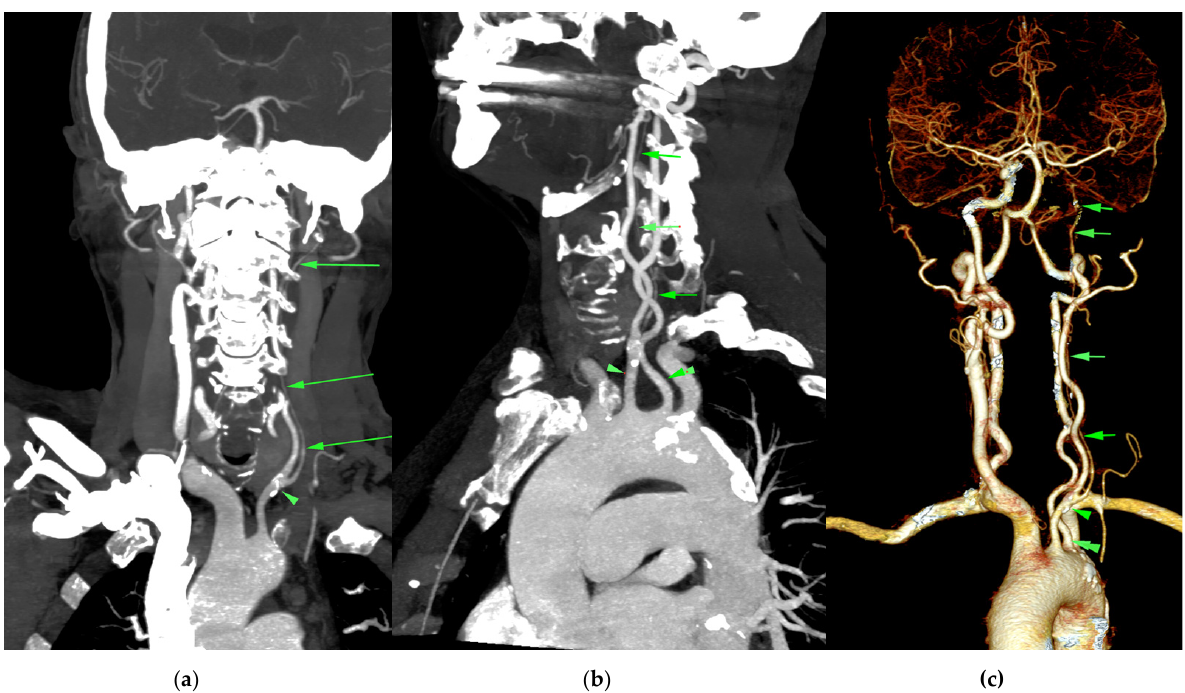
Figure 1. Cervicocerebral 3D CT angiography reconstruction: ( a ) MIP coronal; ( b ) MIP oblique sagittal; ( c ) VRT. The left CCA has a low-lying bifurcation (arrowhead) at approximately 2 cm from the aortic arch. The left ICA has a filiform trajectory (multiple green arrows). The left VA has an anomalous origin from the aortic arch (bold arrow). Compensatory hyperplasia of the contralateral CCA and ICA and both vertebral arteries.